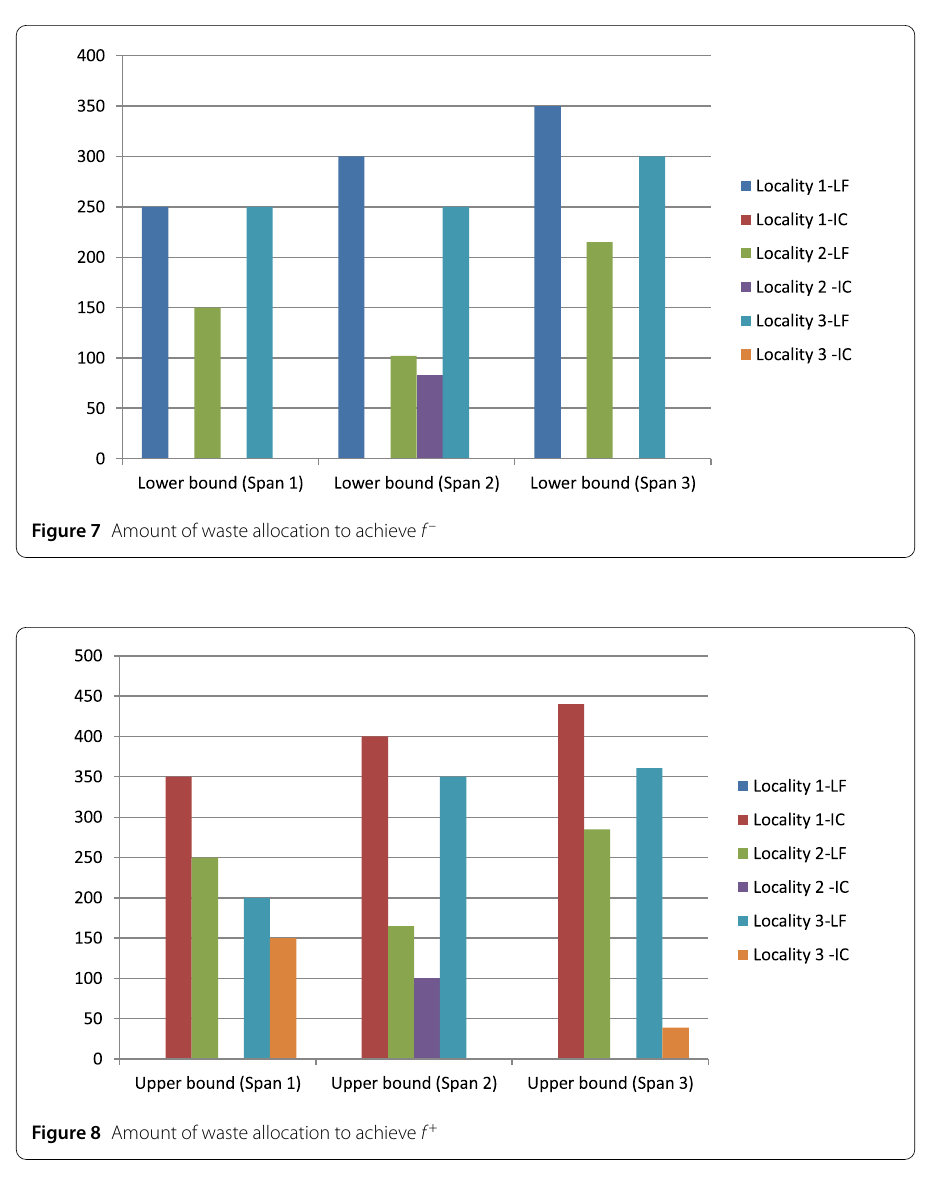
Max f ( x ) = x 2 + y 2 – λ 1 – λ 2 subject to – 2 x + λ 1 – δ 1 = –1,